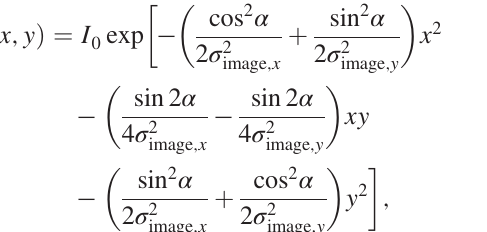
FIG. 2. The pinhole image of the source on the hi-res detector (left-bottom panel). The dotted curves represent the 2 σ and 4 σ contour lines of the fitted 2D Gaussian profile along the dashed axes. The integrated intensity profiles (solid curves) and the Gaussian fitting (dashed curves) in the horizontal and vertical directions are shown in the top and right panels,